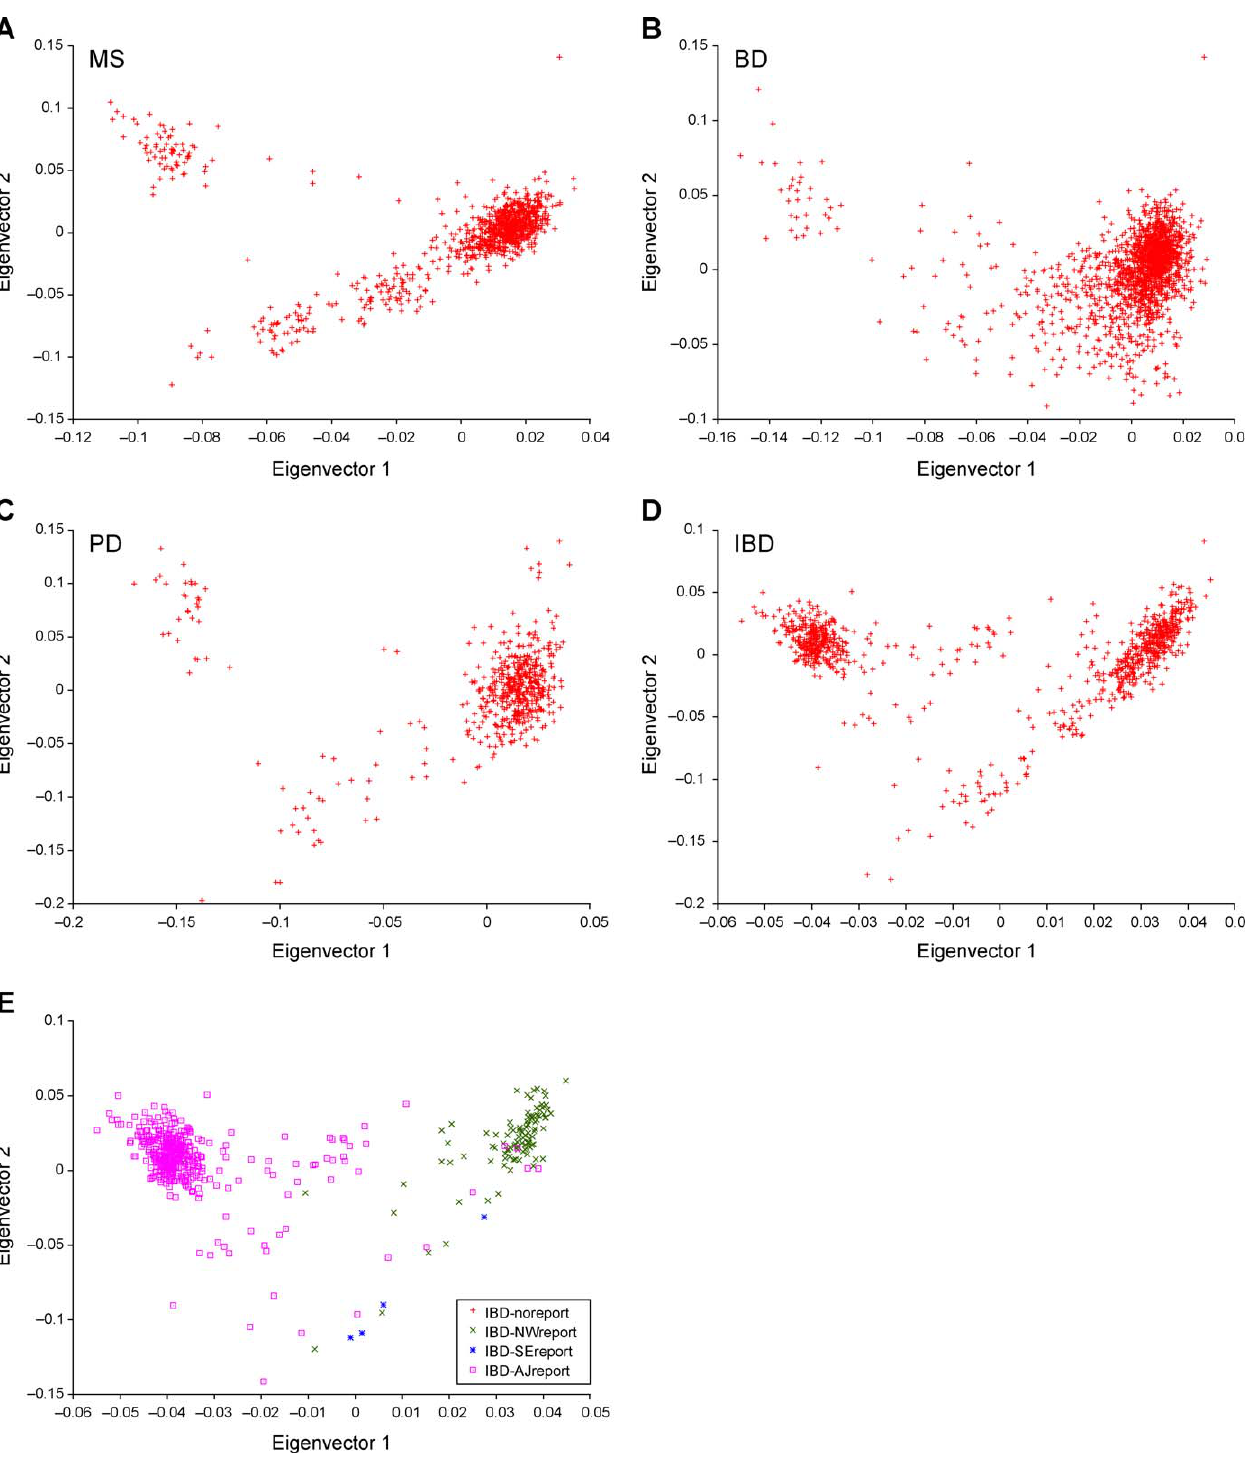
Figure 1. The Top Two Axes of Variation of MS, BD, PD, and IBD Datasets (A) MS dataset, (B) BD dataset, (C) PD dataset, (D) IBD dataset, (E) IBD dataset with samples labeled according to self-reported ancestry (see Methods): northwest European (IBD-NWreport), southeast European (IBD-SEreport) or Ashkenazi Jewish (IBD-AJreport), with individuals having unknown or mixed European ancestry and not self-reporting as Ashkenazi Jewish (IBD-noreport) not displayed.